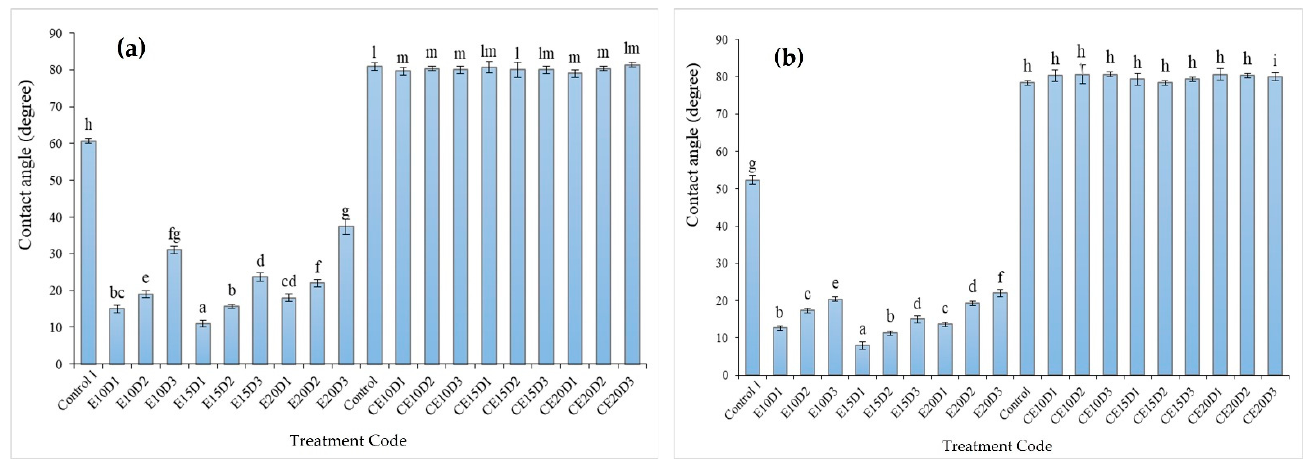
Figure 4. Contact angle value of Control 1, plasma-treated, and plasma-treated and coated PB ( a ) and MDF ( b ). The statistical differences were tested with ANOVA and Duncan test, and the labelled values with the same letter were statistically equal at an error probability of α = 0.05. Error bars represent the standard deviations.